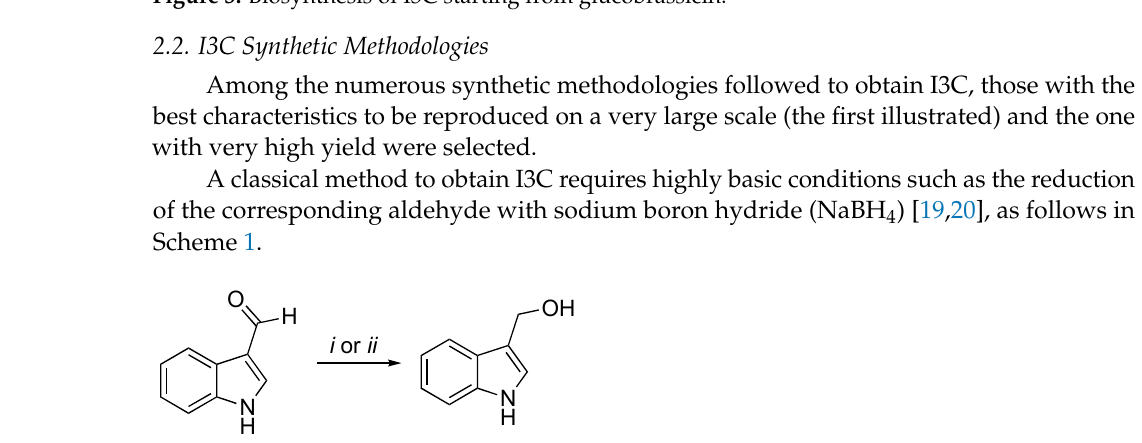
Figure 3. Biosynthesis of I3C starting from glucobrassicin.